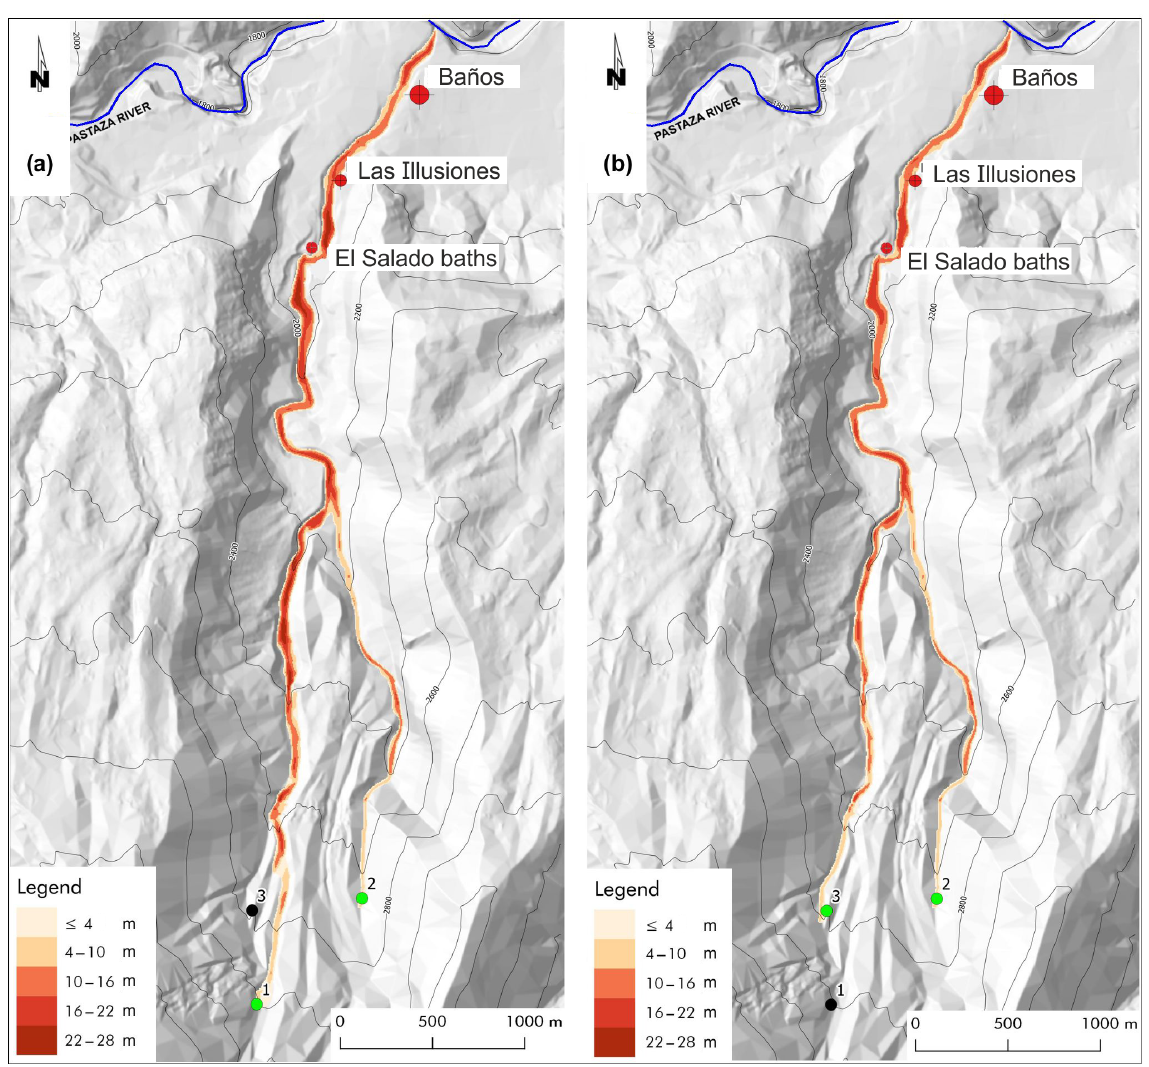
Figure 9. Simultaneous triggering of lahars from points 1 and 2 (a) and from points 2 and 3 (b) . The maximum thickness of the lahar during the conjectured events is reported in meters according the